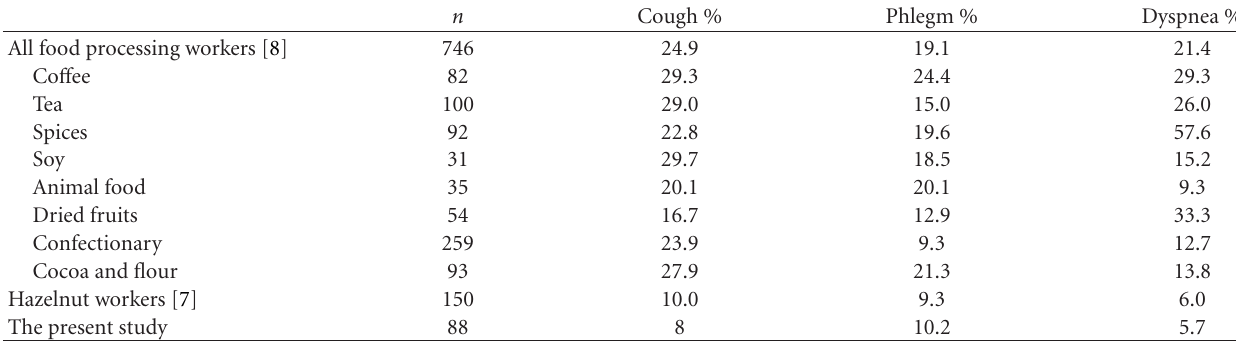
Table 6: Chronic respiratory symptoms of female workers exposed to food processing industries.